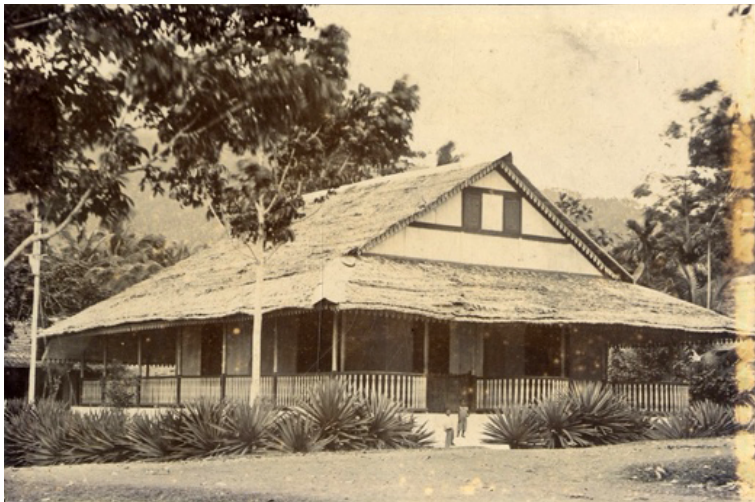
Figure 2. Unknown building on a photo from 1895 in the Colonial Architecture & Town Planning Repository. Source: “Woning, vermoedelijk in Manado,”